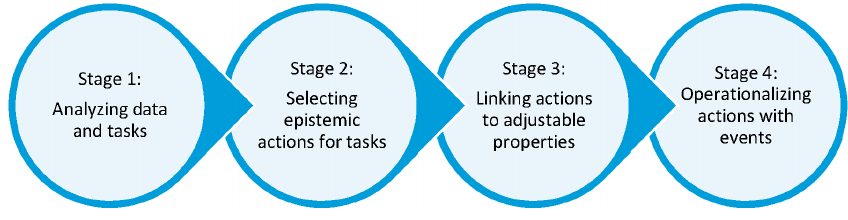
Figure 2. Interaction design process for visualizations.